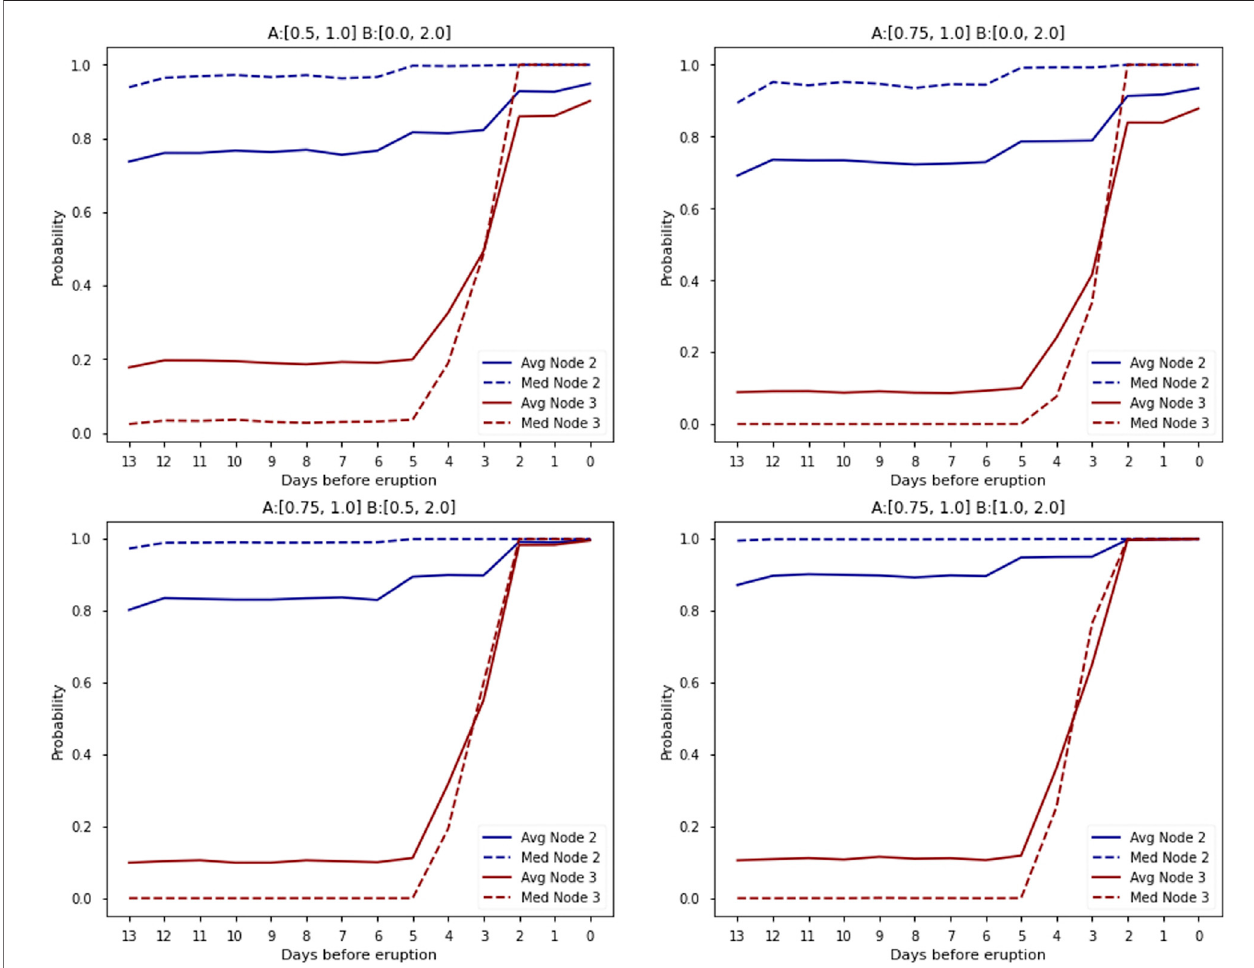
FIGURE 4 | Time evolution of BETEF_AVF output probabilities for magmatic unrest and eruption forecasting for the R ū aumoko scenario for a range of a and b parameter combinations. N.B the probability is a distribution at each time step, but because multiple nodes are presented, we only present the average and median.